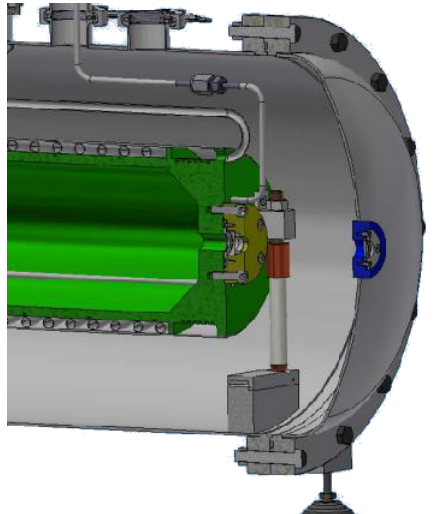
Figure 1. Section of the atmospheric simulation chamber. The sam- ple chamber is indicated in green, while the external chamber is indicated in gray. One of the three insulated supports of the sample chamber can also be observed in addition to the cooling circuit.